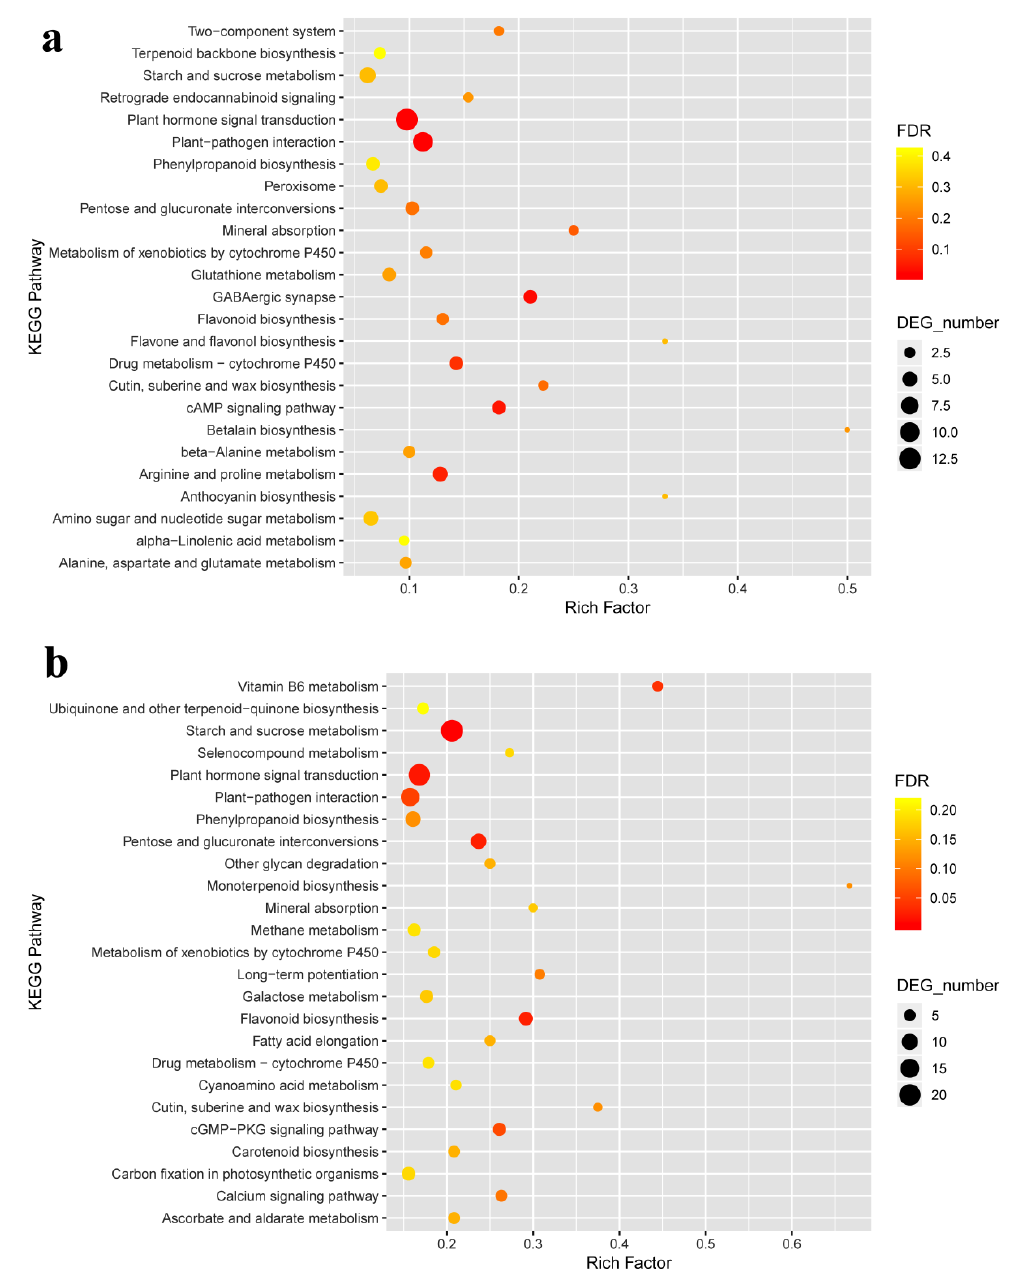
Figure 4. Kyoto Encyclopedia of Genes and Genomes (KEGG) pathway enrichment bubble chart of LJ43 ( a ) and ZN139 ( b ). The Top 25 of pathway enrichment was revealed with low false discovery rate (FDR) (in red colour, significantly) and high FDR (in green colour, insignificantly). X -axis shows the percentage of DEGs in total number of genes involved in corresponding KEGG pathway. Y -axis expresses KEGG pathway. As well, the size of bubble means the number of DEGs in this item.